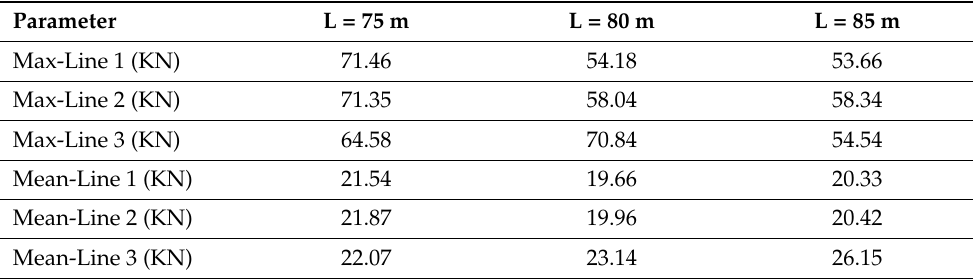
Figure 9. Time series of mooring tension at the fairlead with variations in mooring length, ( a ) Line 1, ( b ) Line 2, ( c ) Line 3. Table 6. Comparison of mooring tensions at the fairleads of foundations with different mooring lengths.